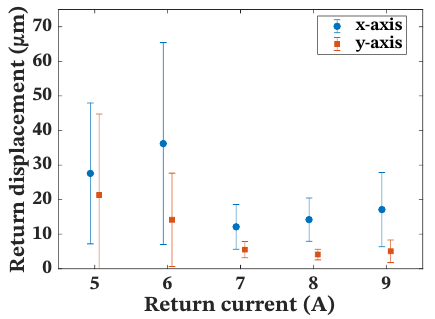
Figure 12. Return current influence on return